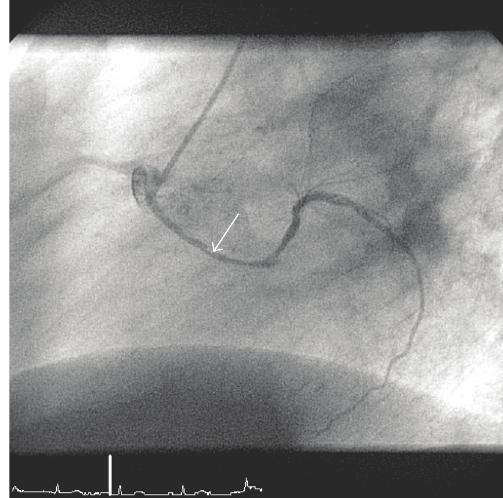
Figure 1: Cardiac catheterization image (LAO) demonstrating the anomalous coronary system. LCx originates from right sinus of valsalva. Mind the retro-aortal route of the LCx (arrow depicts both spiralling course of LCx around the aorta and significant stenosis in LCx).